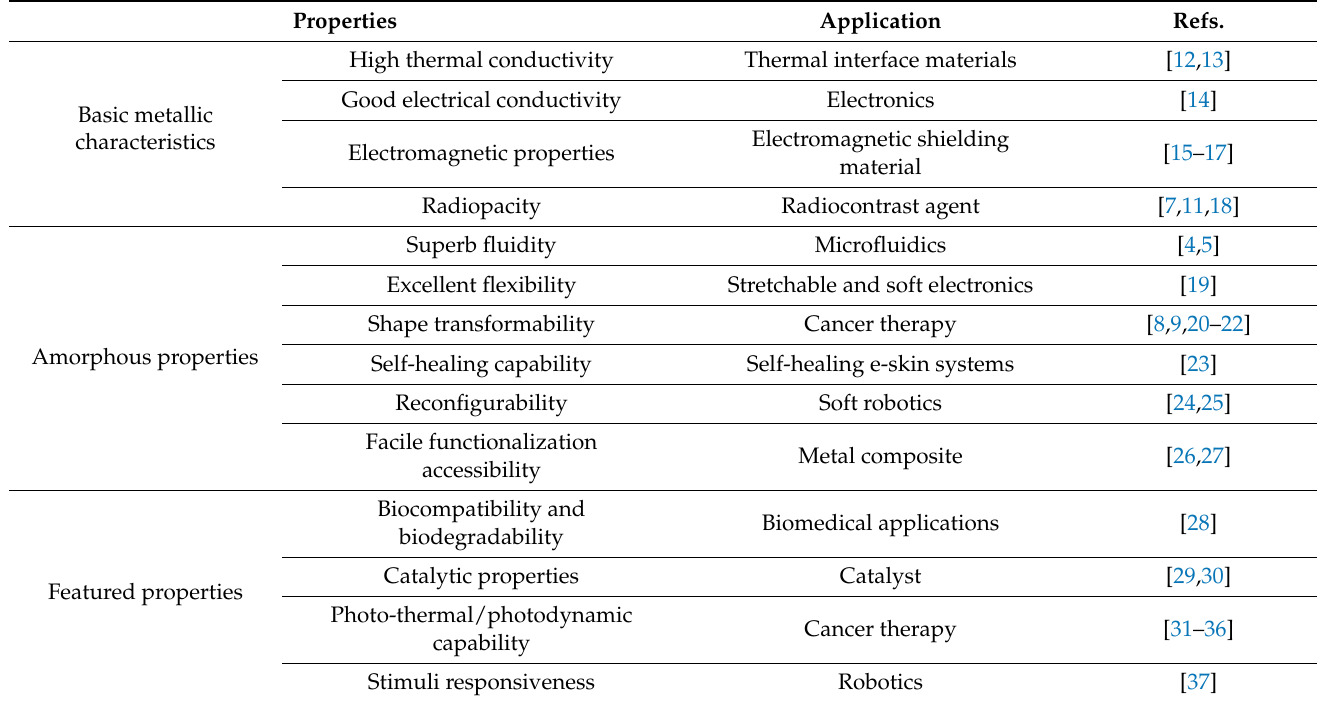
Table 1. Ga-based liquid metal (LM) properties and